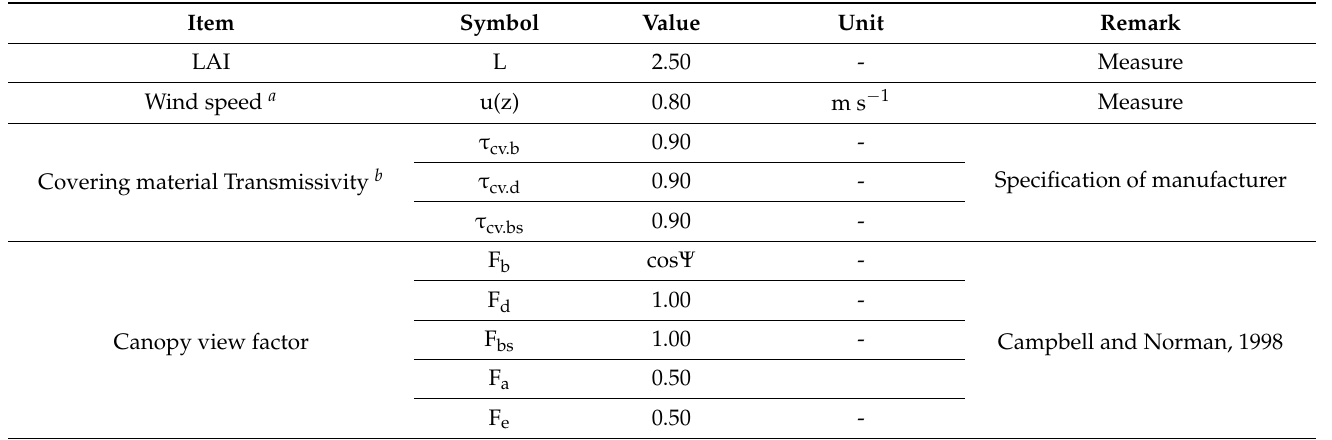
Table 3. Input variables to prove Equations (32) and